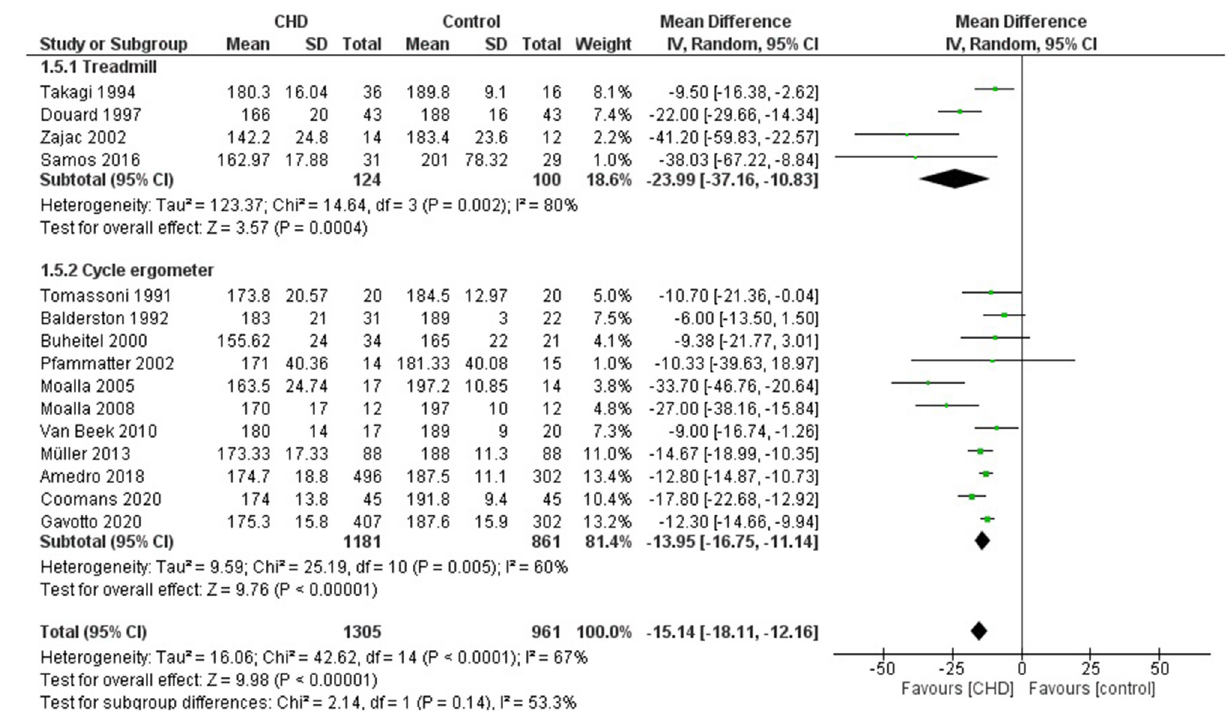
presence of pulmonary hypertension (PH) is also a condition that could affect exercise capacity evaluated through VO 2